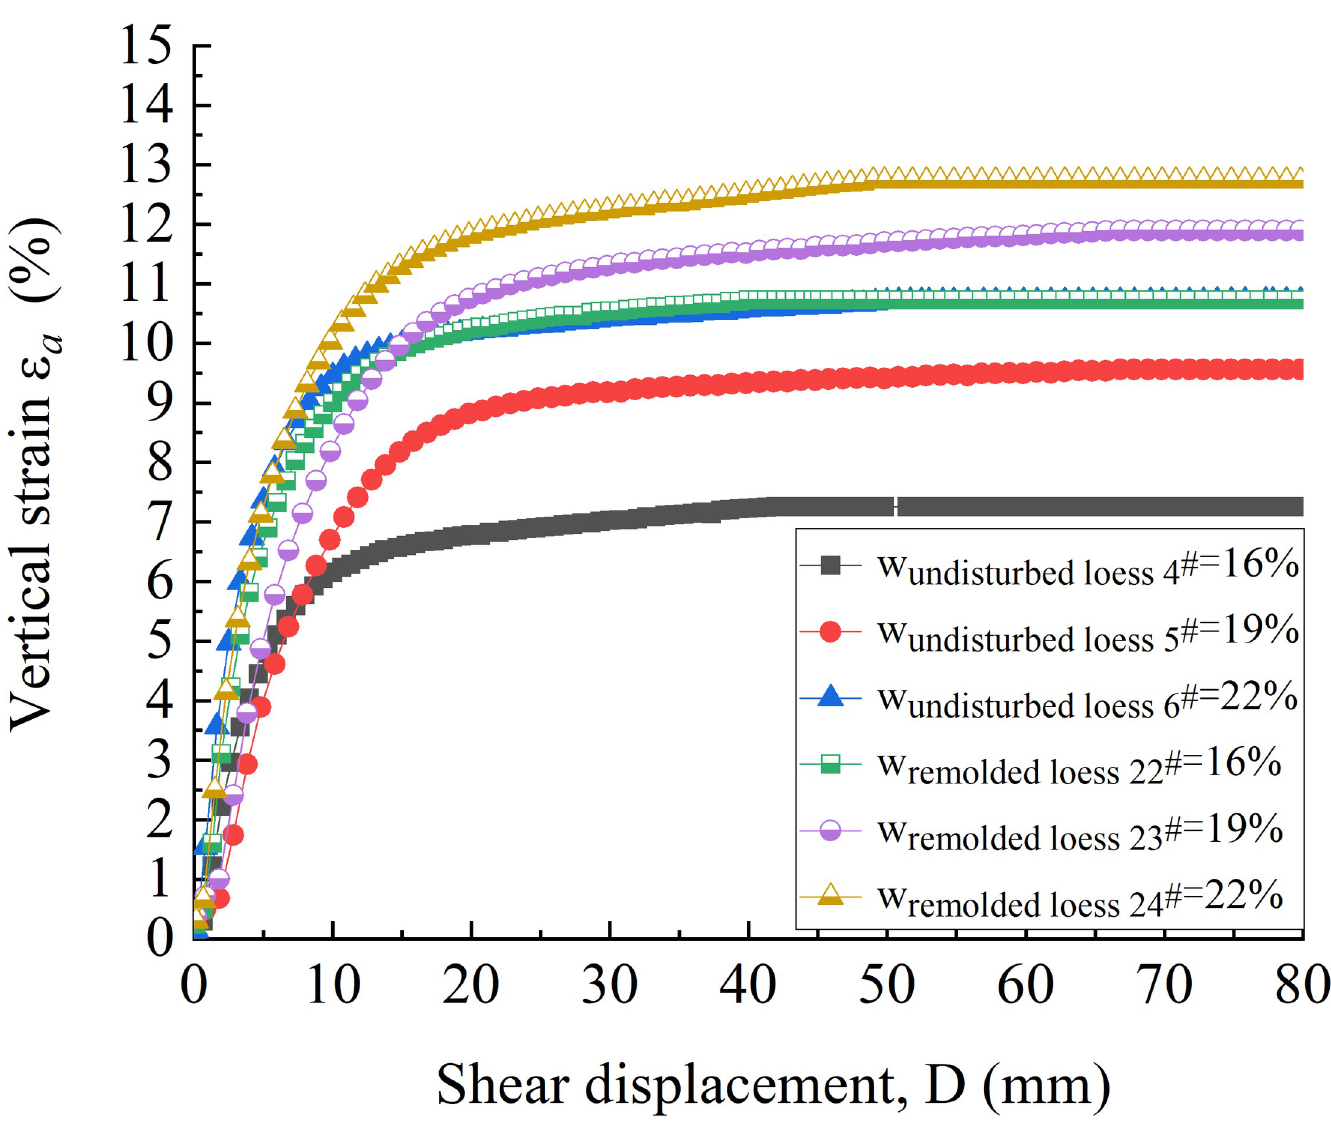
Fig 11. Vertical strain-shear displacement curve of 4 # - 6 # undisturbed and 22 # - 24 # remolded loess specimens under different water content.